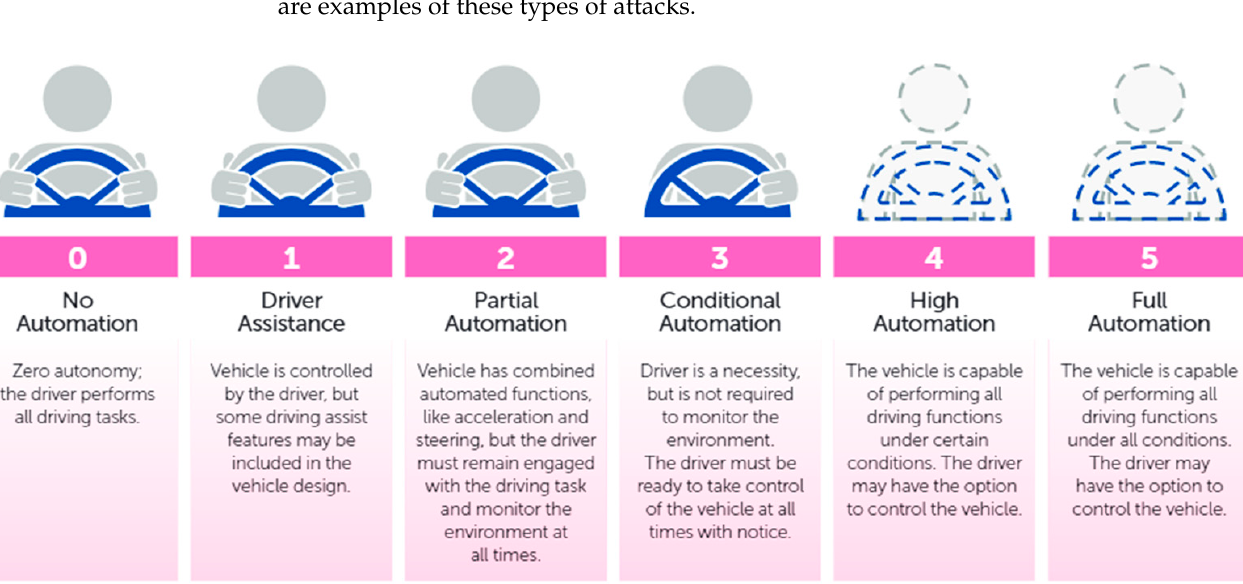
Figure 1. Levels of autonomous driving by NHTSA.